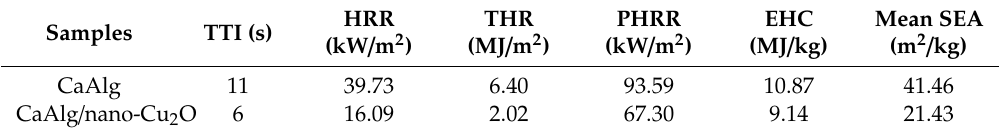
Table 1. CONE test results of CaAlg and CaAlg / nano-Cu 2 O. HRR = heat release rate; THR =